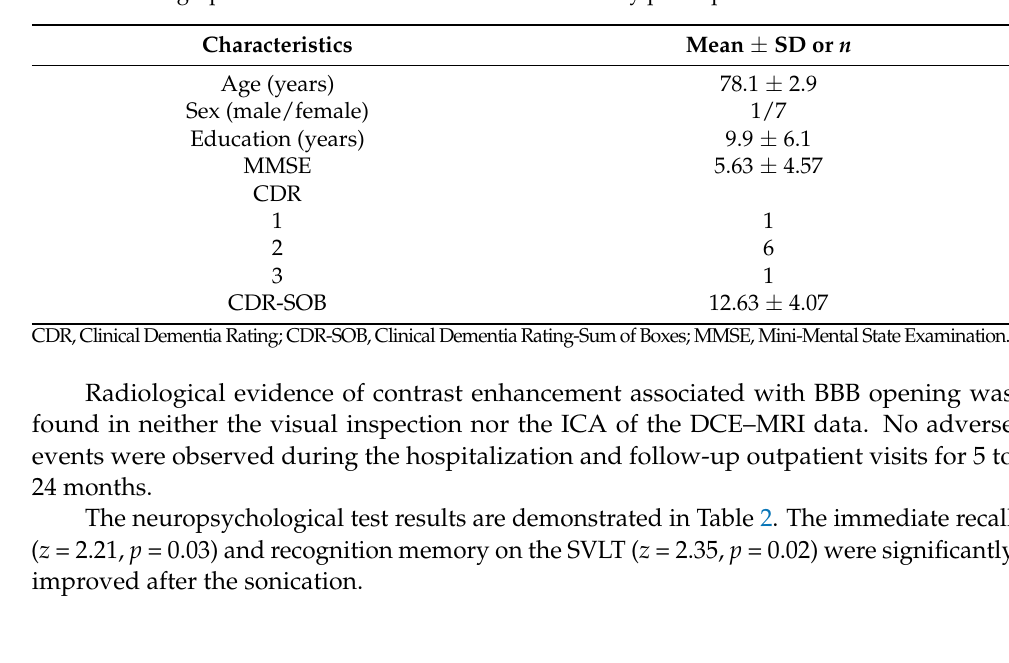
Table 1. Demographic and clinical characteristics of the study